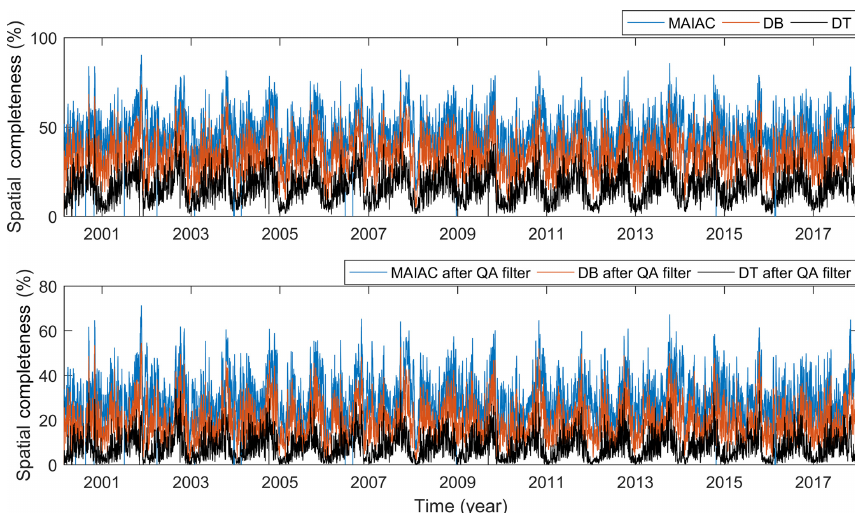
Figure 15. Daily spatial completeness for MAIAC, DT, and DB from 2000 to 2017 before and after the QA filter. Table 6. Seasonal averaged spatial completeness for MAIAC, DT, and DB before and after the QA filter and their declining proportions after the QA filter. All year Spring Summer Autumn Winter Before QA